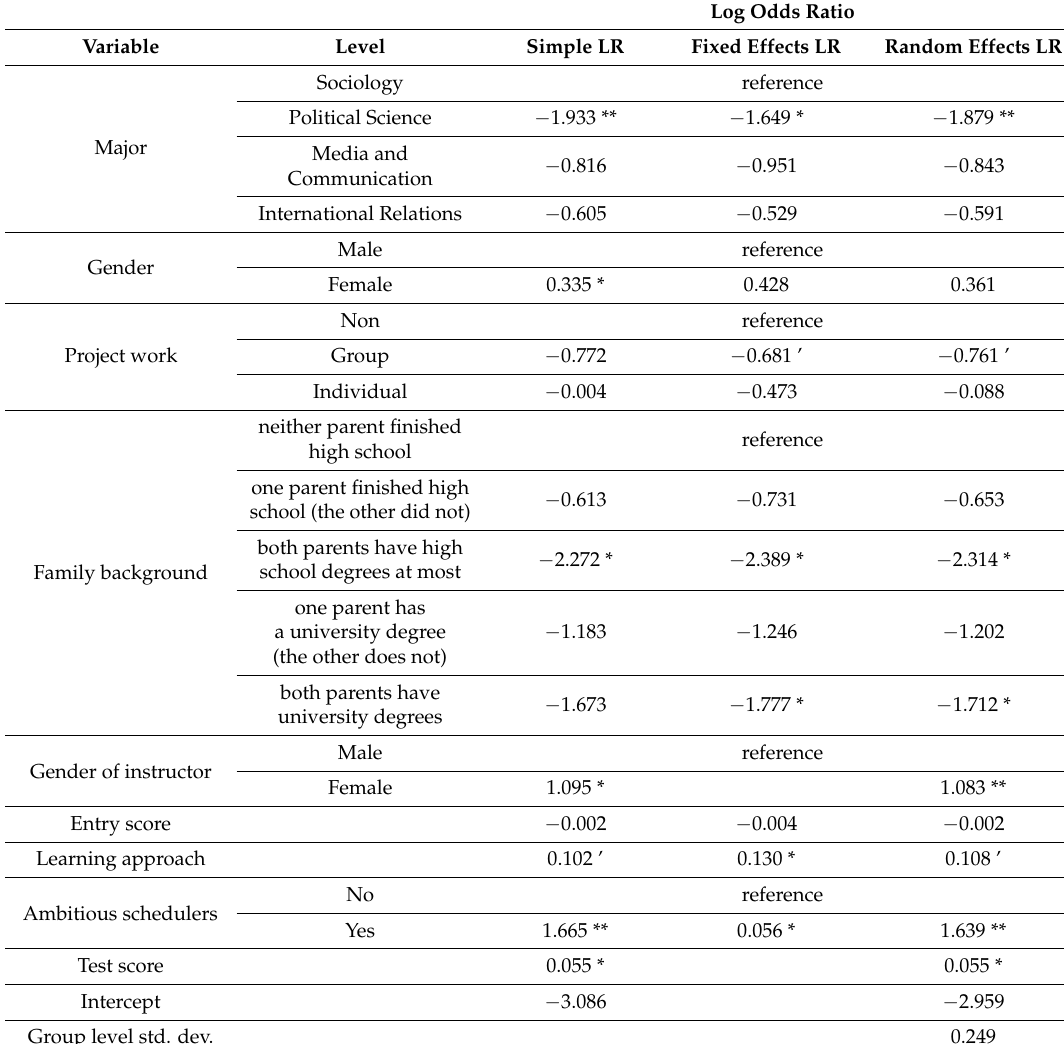
Table 1. Regression coefficients for the three models: simple-, fixed effects-, and random effects logistic regression